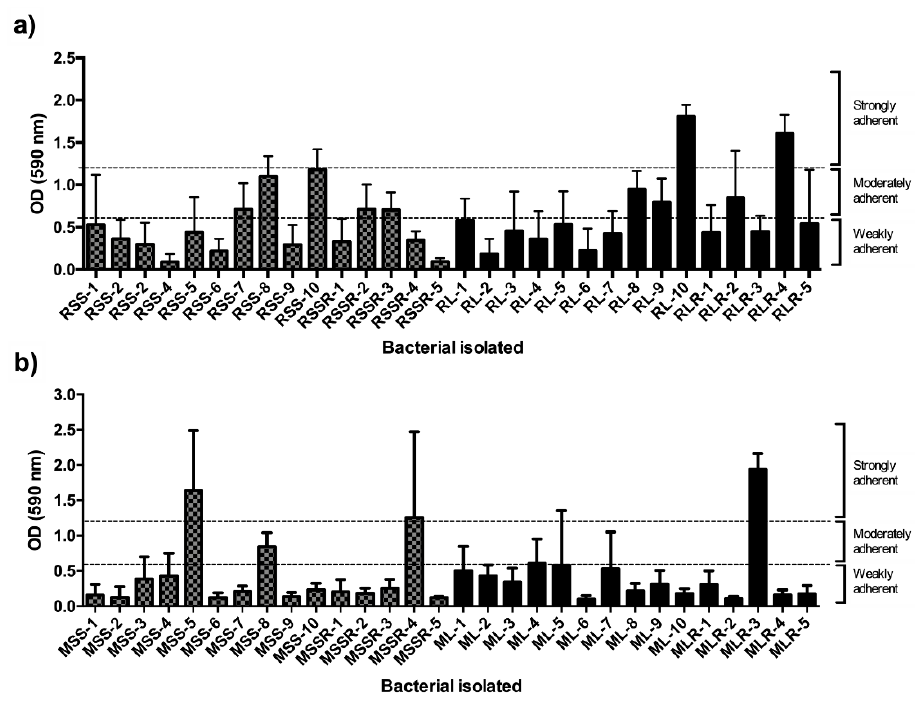
Figure 5. Biofilm formation quantified by staining with crystal violet of isolates from ( a ) R. officinalis and ( b ) M. spicata (RSS-number or RSSR-number: isolates from R. officinalis inorganic fertilizer, RL-number or RLR-number: isolates from R. officinalis vermicompost leachate, MSS-number or MSSR-number: isolates from M. spicata inorganic fertilizer, and ML-number or MLR-number: isolates from M. spicata vermicompost leachate.